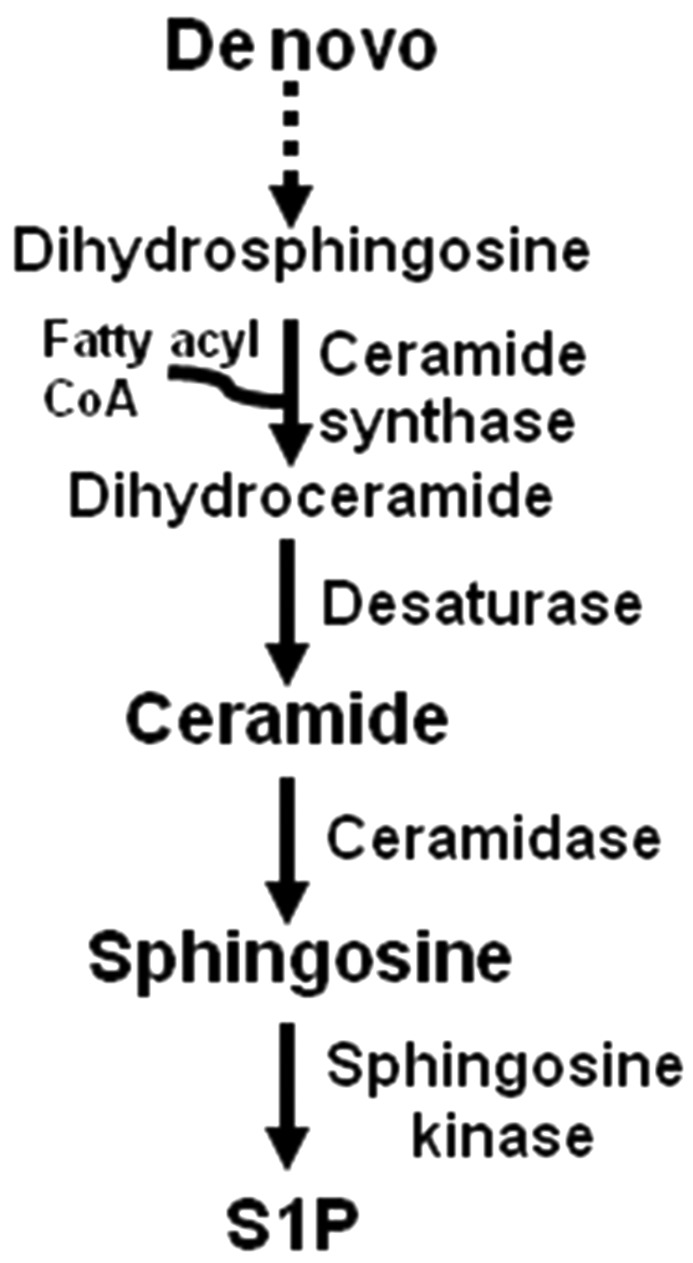
Ceramide metabolism.